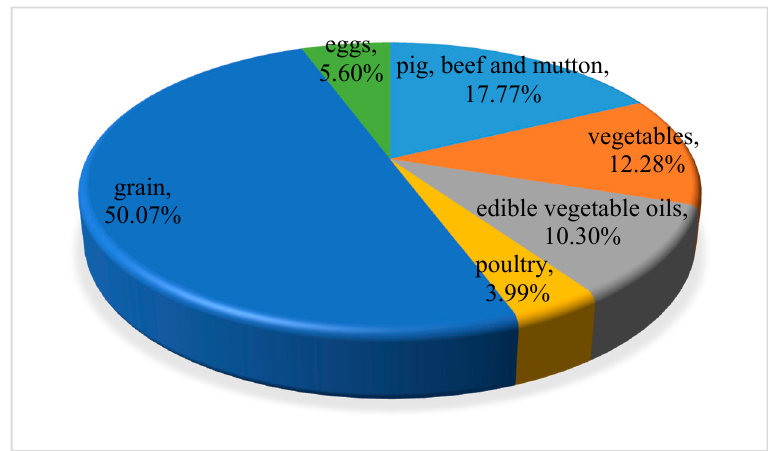
Figure 6. The proportion of water footprint consumed by each type of food of rural residents. On the other hand, a big problem related to food consumption is food waste. A large amount China lost or wasted about 19% of its grain, equivalent to wasting 135 billion m 3 of water